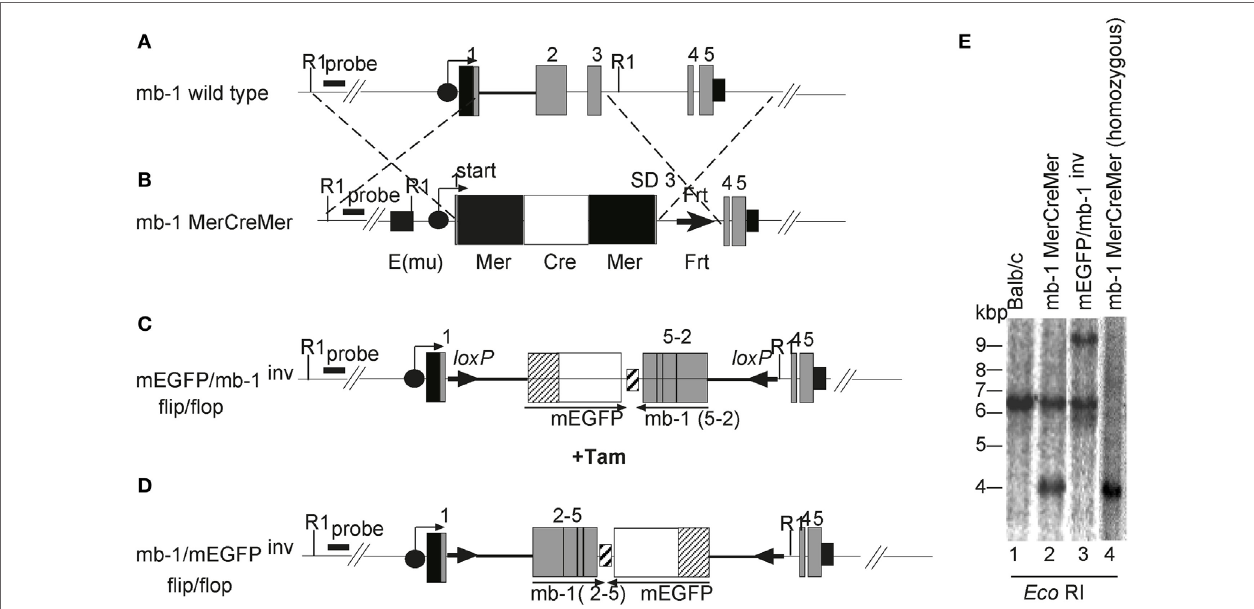
FigUre 1 | Generation of mice carrying a modification at the mb-1 locus. Schematic representations of (a) the mb-1 wild-type allele and the knockin alleles, (B) mb-1 MerCreMer, (c) membrane-bound form of the enhanced green fluorescent protein (mEGFP)/mb-1 inv , and (D) mb-1/mEGFP inv (not drawn to scale). The mb- 1MerCreMer strain was crossed to either mEGFP/mb-1 inv or mb-1/mEGFP inv to generate the imb-1 and the cmb-1 strains, respectively. The black circles with an arrow represent the mb-1 promoter. The gray boxes indicate the mb-1 exons, and the small black box after exon 5 represents the 3 ′ untranslated region and the mb-1 polyA sequence. In (B) , the black square 5 ′ of the mb-1 promoter represents the immunoglobulin heavy chain intron enhancer (Emu), the black and white boxes represent (Mer) and the humanized Cre (hCre), respectively. The black triangle indicates the Frt site left after deletion of the Neo r cassette by the transient transfection with the enhanced flp recombinase (flpe). Constructs (c,D) were previously described in Ref. (47). (e) Southern blot analysis of mEGFP/mb-1 inv and mb-1 MerCreMer heterozygous mice relative to wild-type control. Genomic DNA was prepared from tails of the designated mice, digested with Eco RI and hybridized with a radioactive labeled 5 ′ external probe to identify the homologously recombined alleles. The analysis by Southern blot gives 4.1 and 9.6 kb fragments for the DNA targeted with MerCreMer and the “flip/flop” cassette (mEGFP/mb-1 inv or mb-1/mEGFP inv ), respectively ( Figure 1e , lanes 2 and 3 and data not shown). Wild-type DNA generates a 6.4 kb fragment with the same enzyme ( Figure 1e , lane 1). Lane 4 represents an mb-1 MerCreMer homozygous